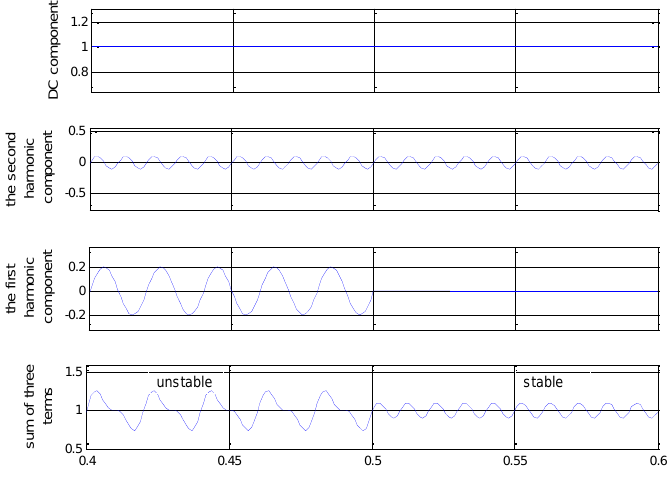
Figure 2. Illustration of stable and unstable operation of the converter.